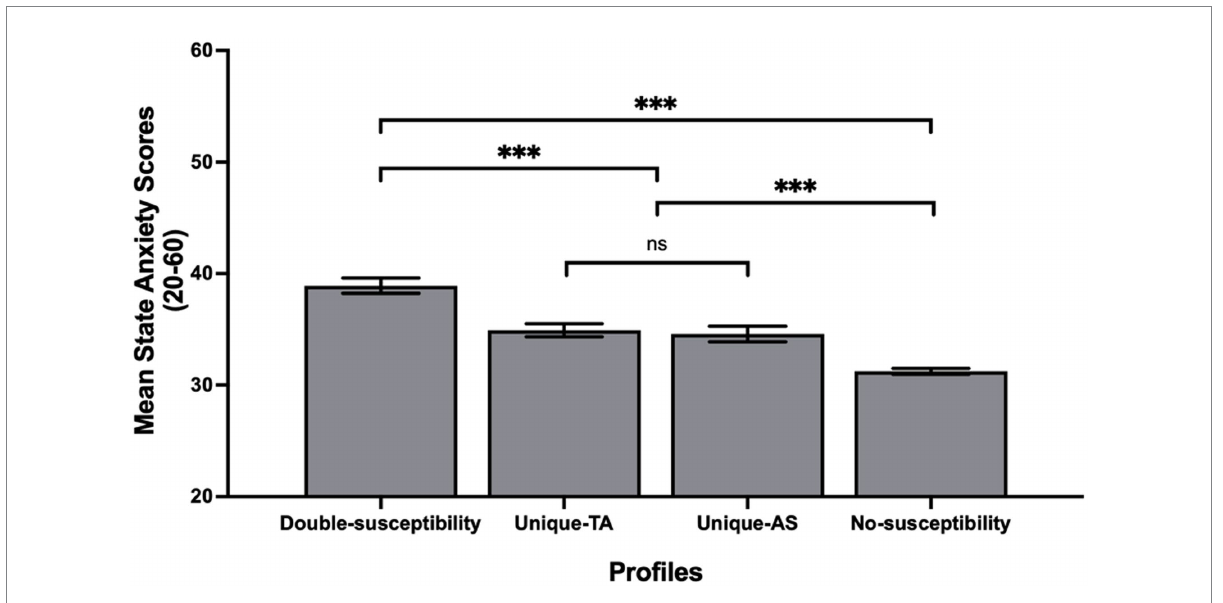
FIGURE 4 Levels of state anxiety as a function of students’ latent profile. * p <